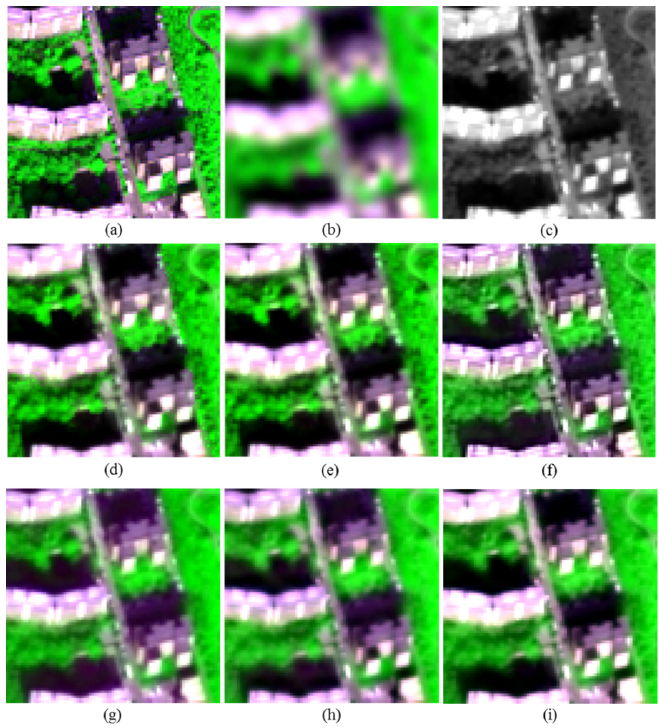
Figure 5. The 84 × 84 pixel subsets of the MS images and the corresponding fused images produced from the degraded WorldView (WV)-2 dataset: ( a ) true 2-m MS image; ( b ) up-sampled version of the 8-m MS image; ( c ) 2-m PAN image; and the results of ( d ) UHR fusion, ( e ) HR fusion, ( f ) PS fusion, ( g ) GS1 fusion, ( h ) GS2 fusion and ( i ) GSA fusion.